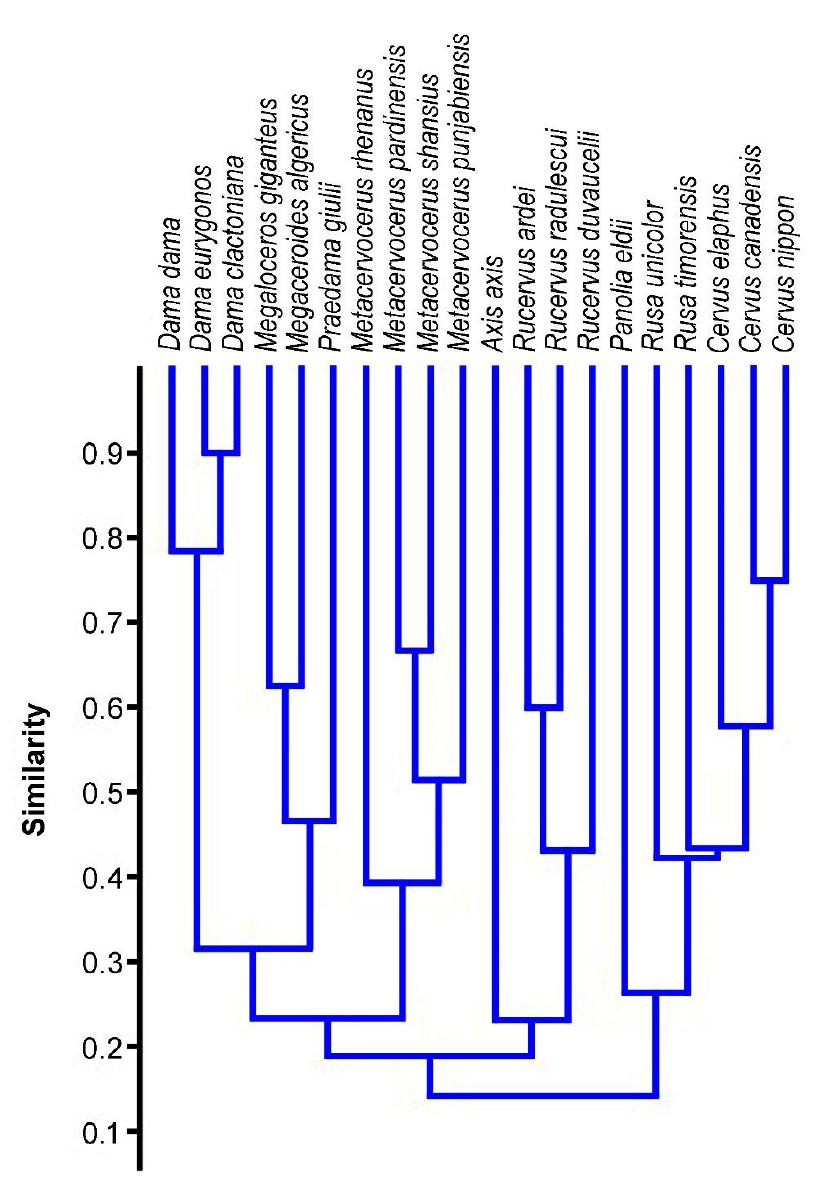
Figure 11. Cluster analysis of the diagnostic antler, cranial, and dental characters of Megaloceros giganteus and related species, as well as selected modern and extinct representatives of the subfamily Cervinae. The cophenetic correlation coefficient is 0.8342.